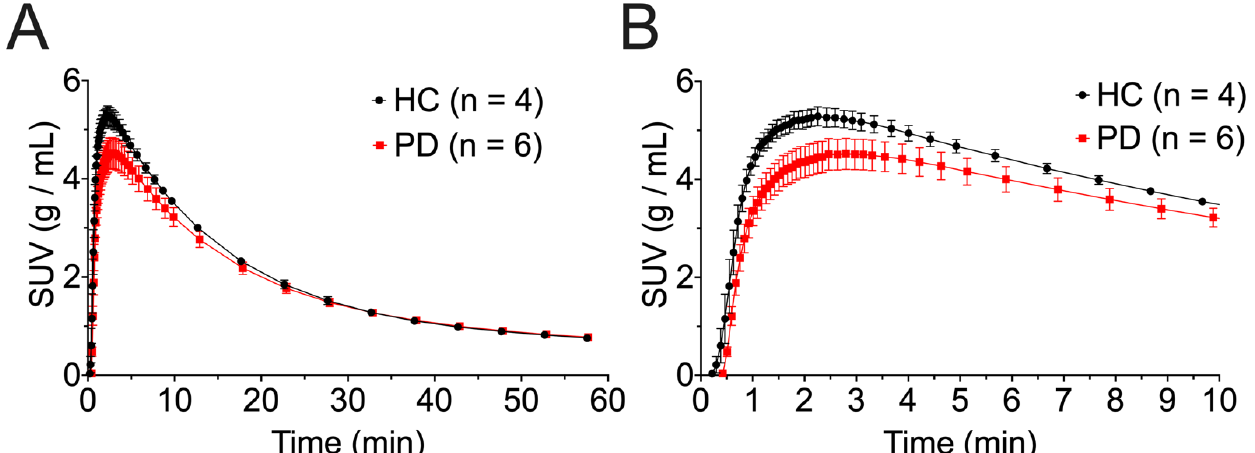
Figure 1. Whole-brain [ 18 F]NOS time activity curves for healthy controls (HC) and PD patients from ( A ) 0 – 10 min post-injection and ( B ) 0 – 60 min post-injection. Curves are plotted as mean ± standard deviation.